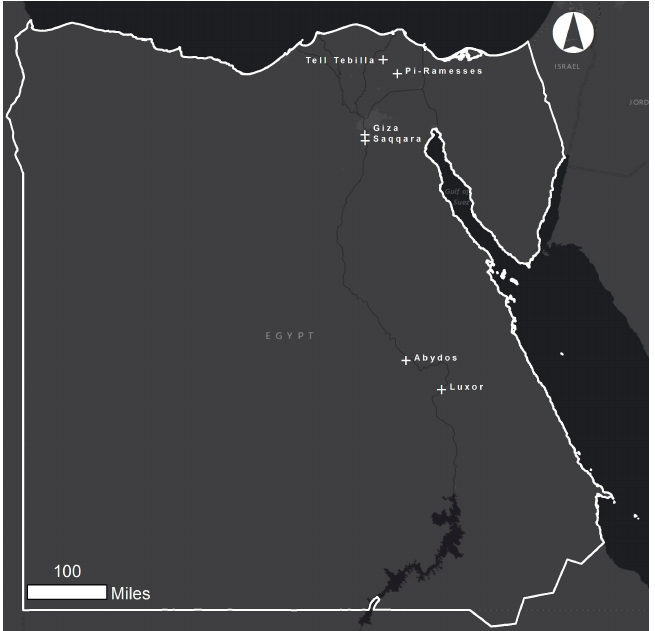
Figure 4. Map of key sites where magnetometry work has taken place. Image courtesy Chase Childs.